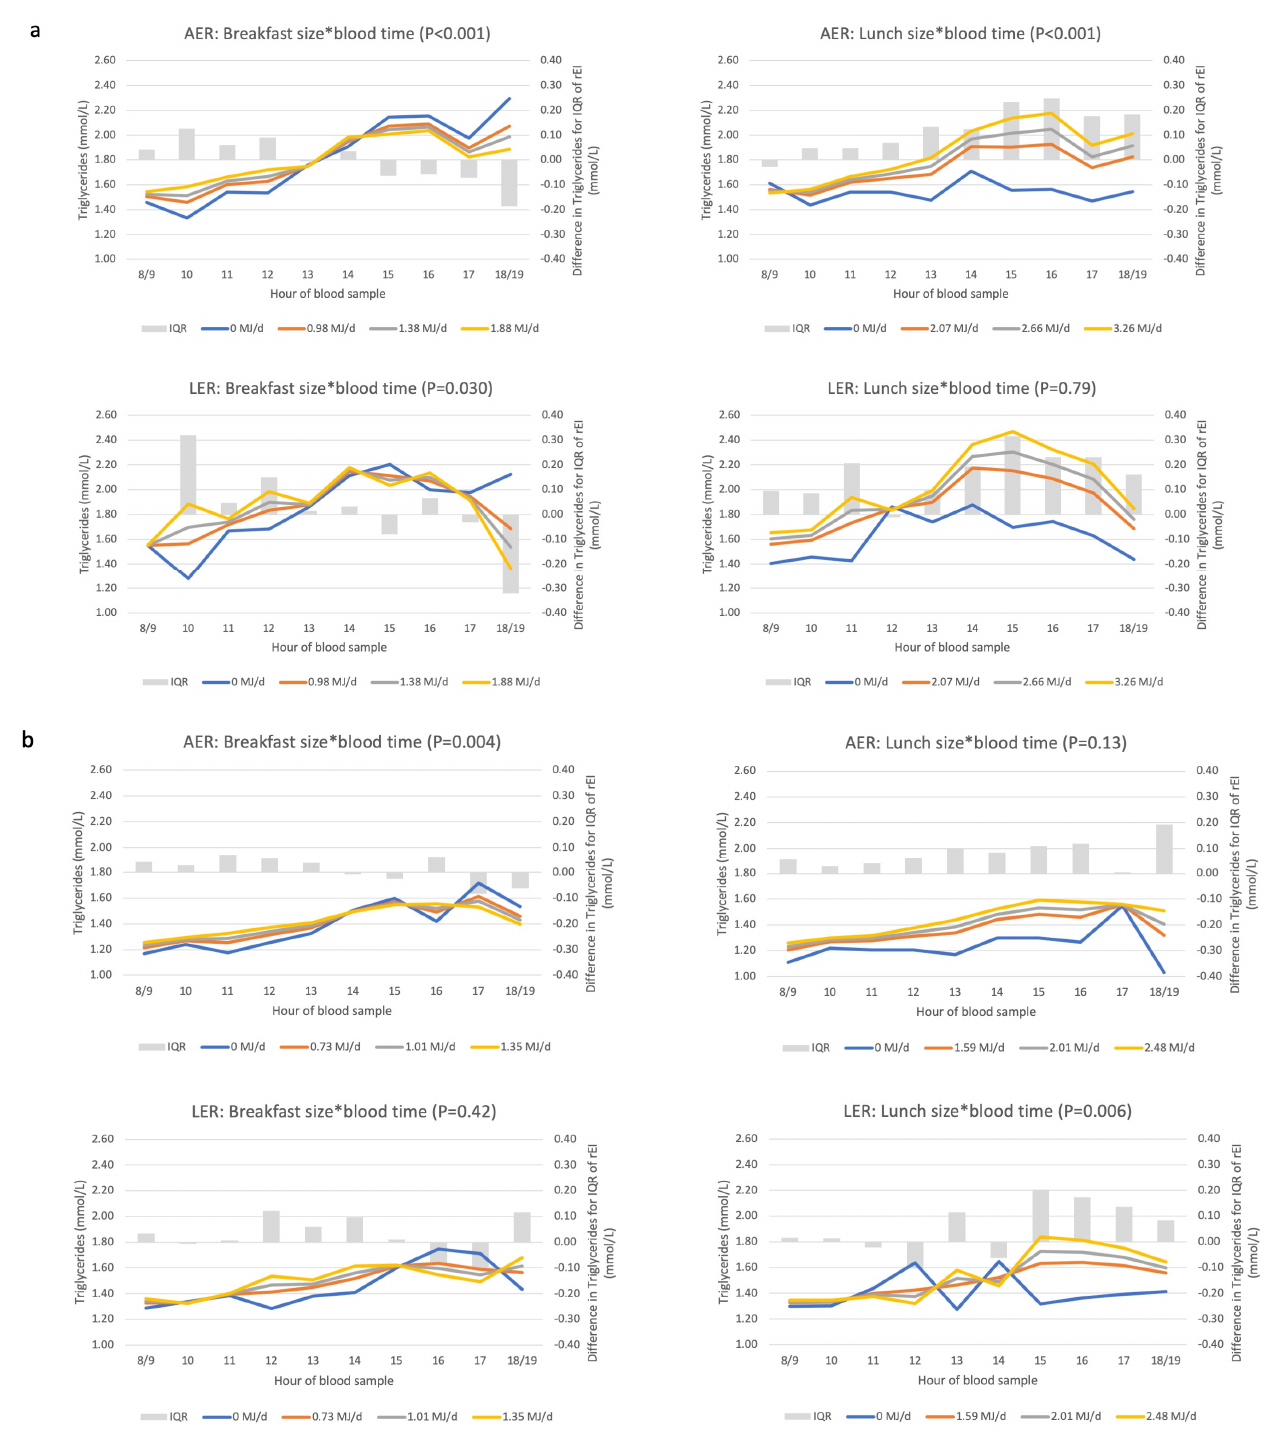
Figure 6. Associations between rEI (‘meal size’) and triglyceride concentrations by reporting status in men ( a ) and women ( b ). Abbreviations: AER, acceptable energy reporter; DEI, daily energy intake (MJ/d); IQR, interquartile range; LER, low energy reporter; rEI, reported energy intake. See Appendix D for a description of the axes and Table S3 for a description of LER and AER.